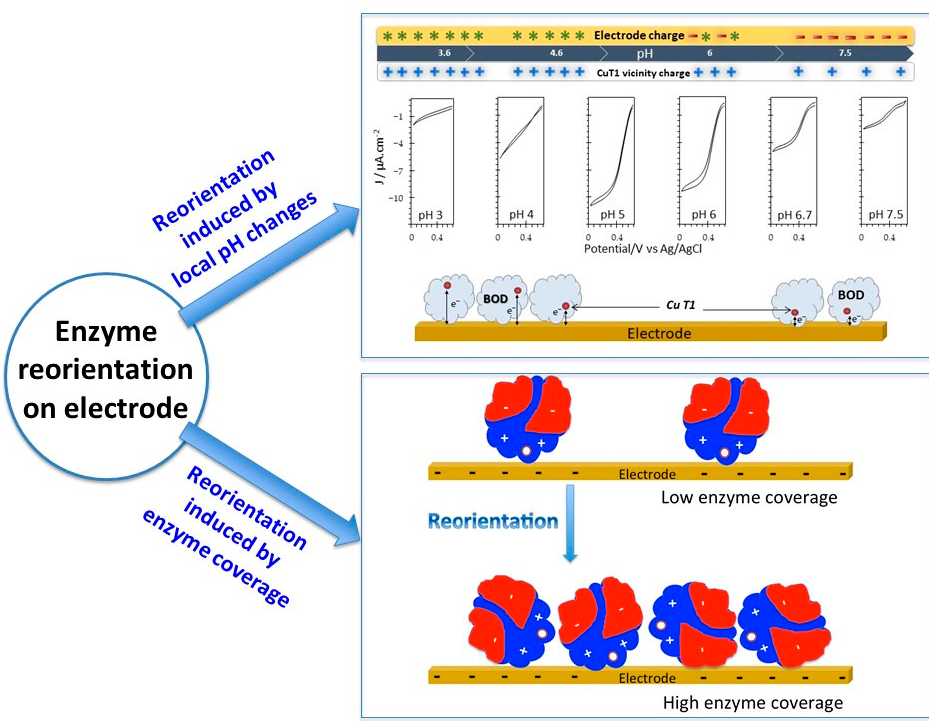
Figure 13. Reorientation of enzymes on electrode may alter enzyme stability. ( Top ) Tuning the pH of the electrolyte induces rotation of the adsorbed bilirubin oxidase on the electrode surface, hence induces modification in bioelectrocatalysis for O 2 reduction. Adapted with permission from [116]. ( Down ) Scheme of the reorientation of enzymes on an electrode induced by surface coverage. The white sphere represents the active site. Adapted with permission from [115].